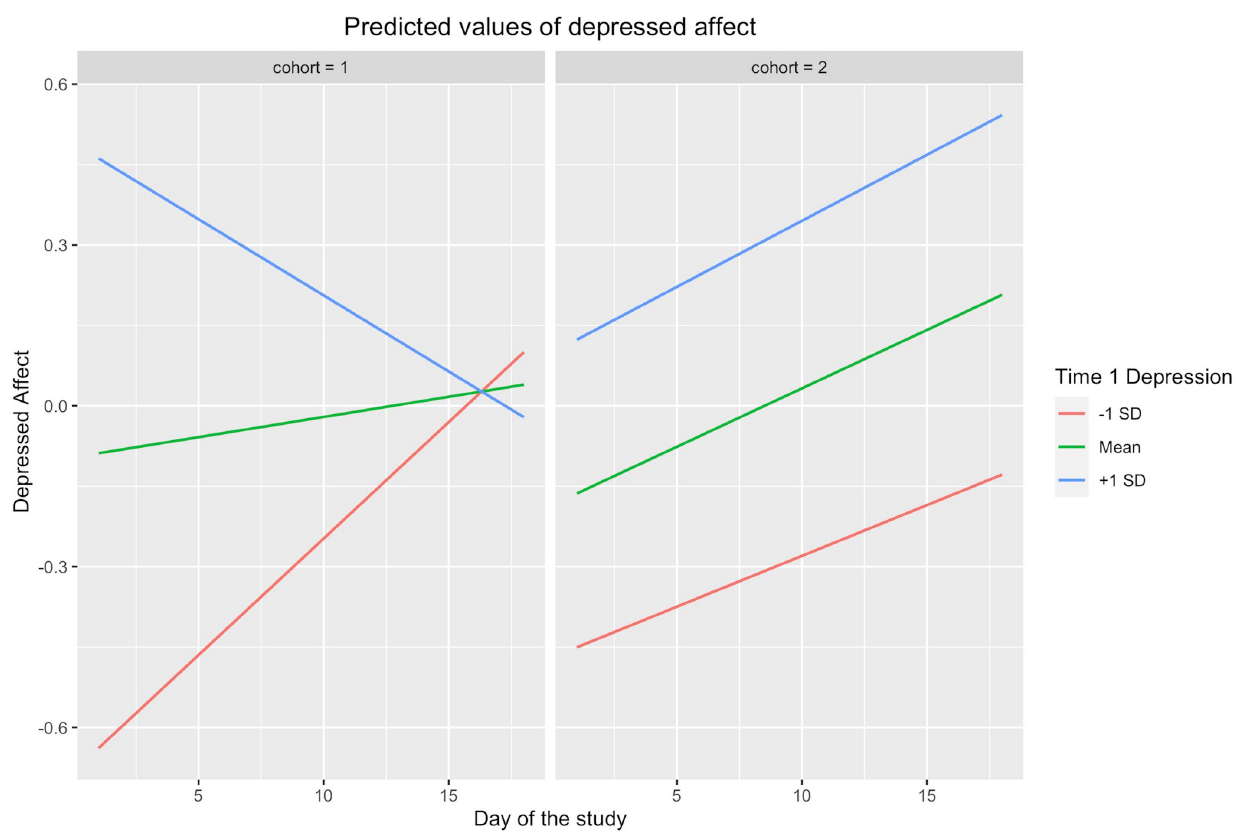
Fig 1. Predicted values of depressed affect from Year × Day × Time 1 BDI-II interaction. Cohort 1 = 2019; cohort 2 = 2020.